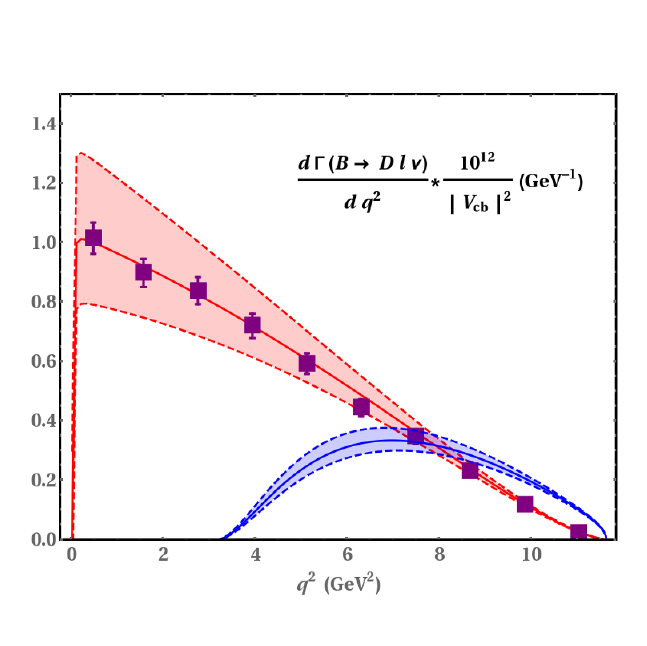
Figure 8 . The di(cid:11)erential decay rates for B ! D(cid:22)(cid:23) (cid:22) (pink band) and B ! D(cid:28)(cid:23) (cid:28) (blue band) as a function of the momentum transfer squared q 2 , where the experimental data points for B ! D(cid:22)(cid:23) (cid:22) (purple squares) from the Belle Collaboration [71] are also presented for a comparison.